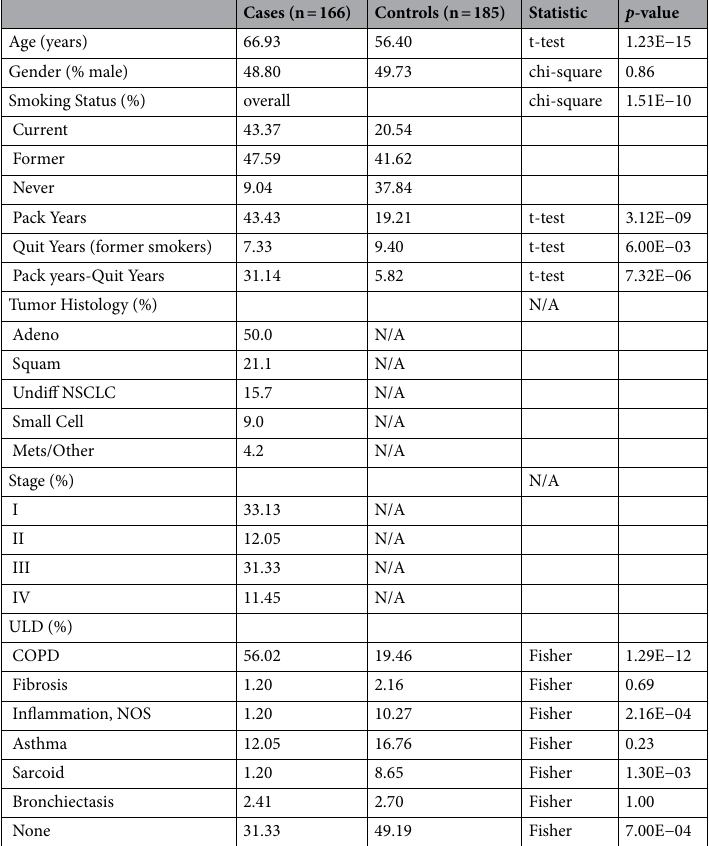
Table 2. Clinical characteristics among 351 cases and controls. Clinical characteristics of the case versus control subjects. Former smoker, defined as quit > 1 year; COPD, defined clinically (MD report, medications), radiographically, and/or pathologically (where available) in medical records; Pack-yrs – Quit-yrs, in former smokers, a constructed composite tobacco exposure risk variable combining cumulative dose (pack years) minus proximity/recency of smoking (quit-years); NOS, not otherwise specified. Adeno = adenocarcinoma; Squamous = squamous cell carcinoma; NSCLC-Undifferentiated non-small cell lung cancer; Small cell = small cell carcinoma; Mets/Other = metastases from other organs to lung or other tumor histologies. ULD = Underlying (chronic) lung